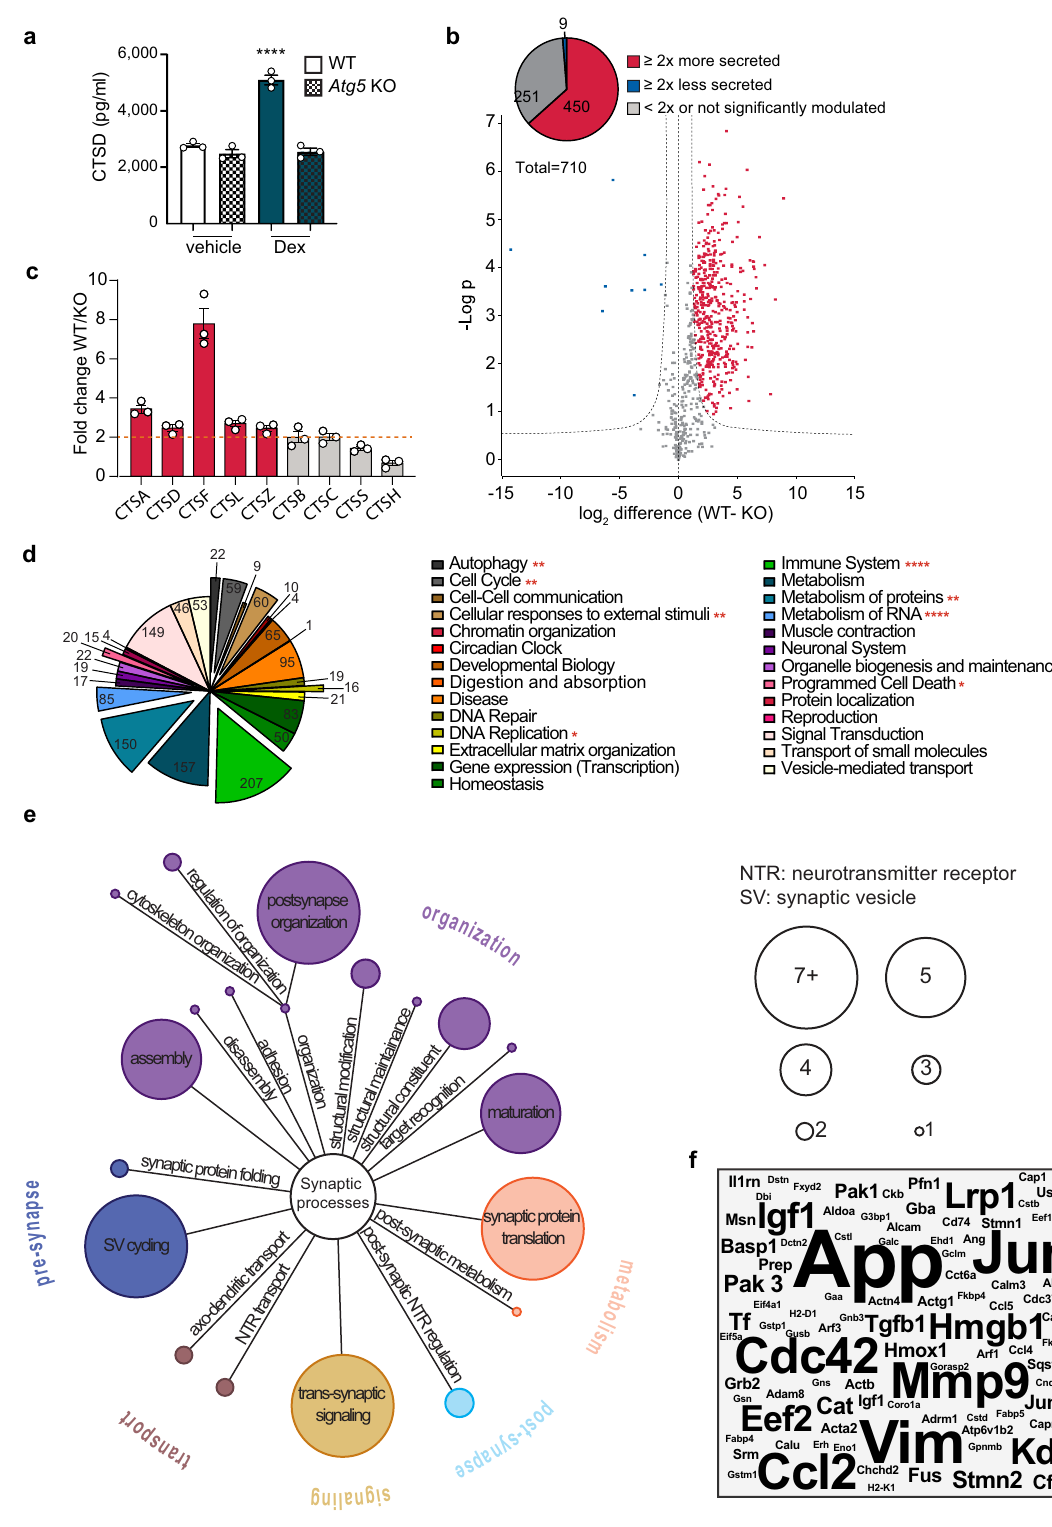
Fig. 3 Detection of novel cargo proteins regulated by stress-induced secretory autophagy. a CTSD from supernatants measured with ELISA after WT or Atg5 KO SIM-A9 cells were treated with 300 nM dexamethasone (Dex) or vehicle for 4 h. Tukey ’ s multiple comparison test was performed; **** p < 0.0001. Signi fi cance refers to WT Dex compared to every other condition. Data shown as mean ± s.e.m. of n = 3 biologically independent samples. b Volcano plot representation of a multiple t -test analysis of the secretome in which each dot represents the replicates ’ mean (difference of WT- Atg5 KO); FDR = 0.01, s0 = 1 of n = 3 biologically independent samples. c Secretion levels of detected cathepsins indicated as fold change of WT over Atg5 KO. Data shown as mean ± s.e.m. of n = 3 biologically independent samples. d GO results performed with Reactome. e GO results performed with SynGO. f Word cloud representation of automated literature mining results in association with “ neuroplasticity ”